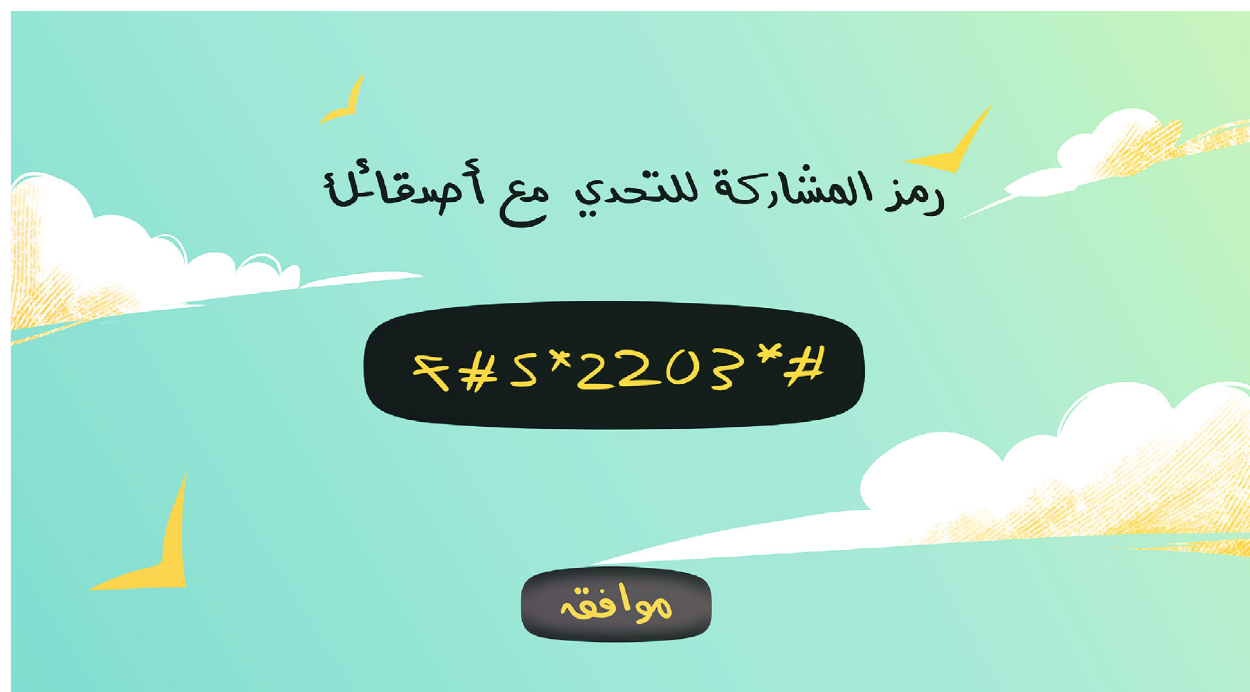
Figure 2: The unique code